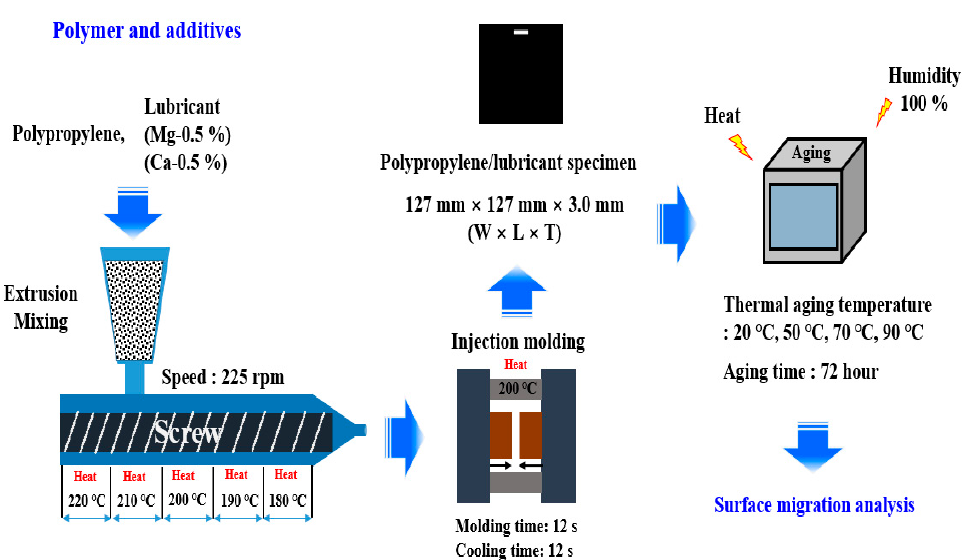
Figure 1. Schematic of procedure followed for the surface migration analysis of Polypropylene/lubricant composites by thermal and humidity aging.